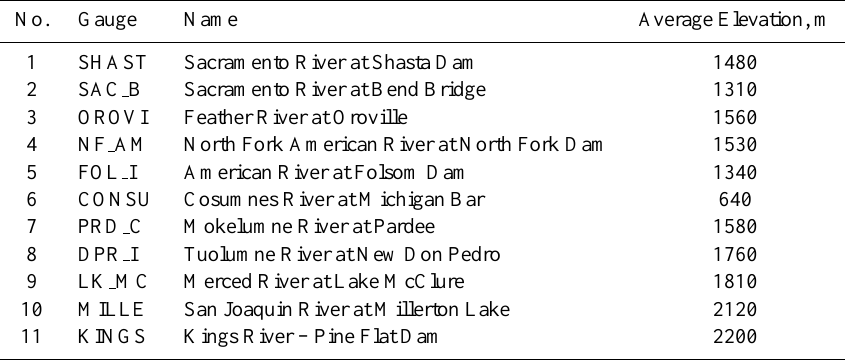
Table 1. Streamflow gauges included in this